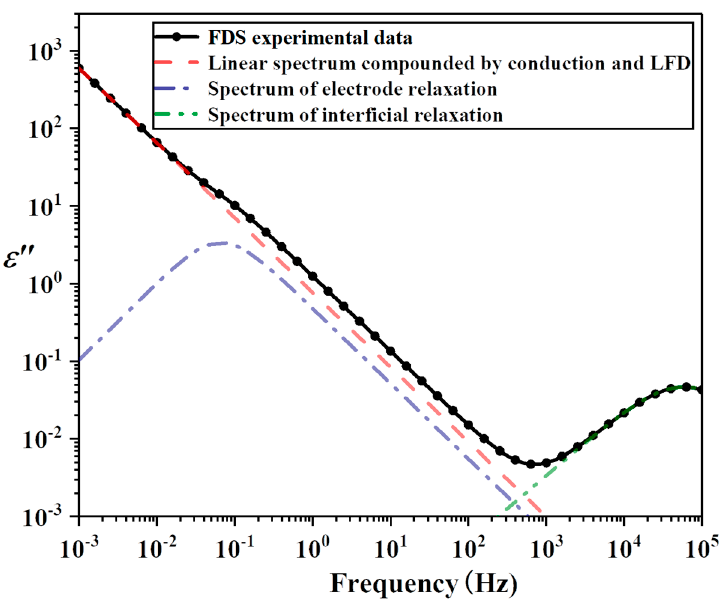
Figure 11. Physical model of FDS tested in a high-temperature